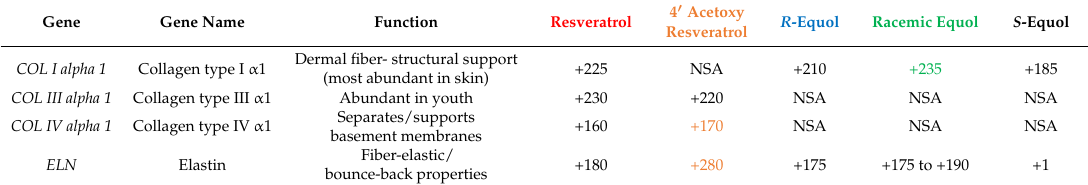
Table 3. Human skin extracellular matrix proteins gene expression among resveratrol, 4 (cid:48) acetoxy resveratrol, R -equol, racemic equol or S -equol as the percentage of the increase (+) compared to